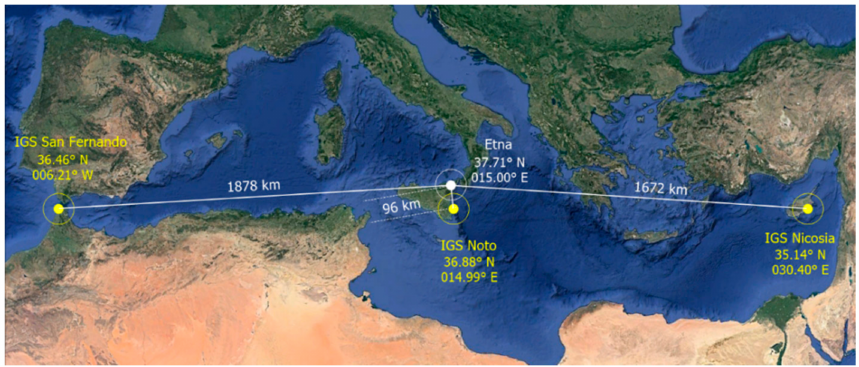
Figure 4. Geographical positions of IGS Noto, IGS San Fernando and IGS Nicosia in relation to the location of Etna